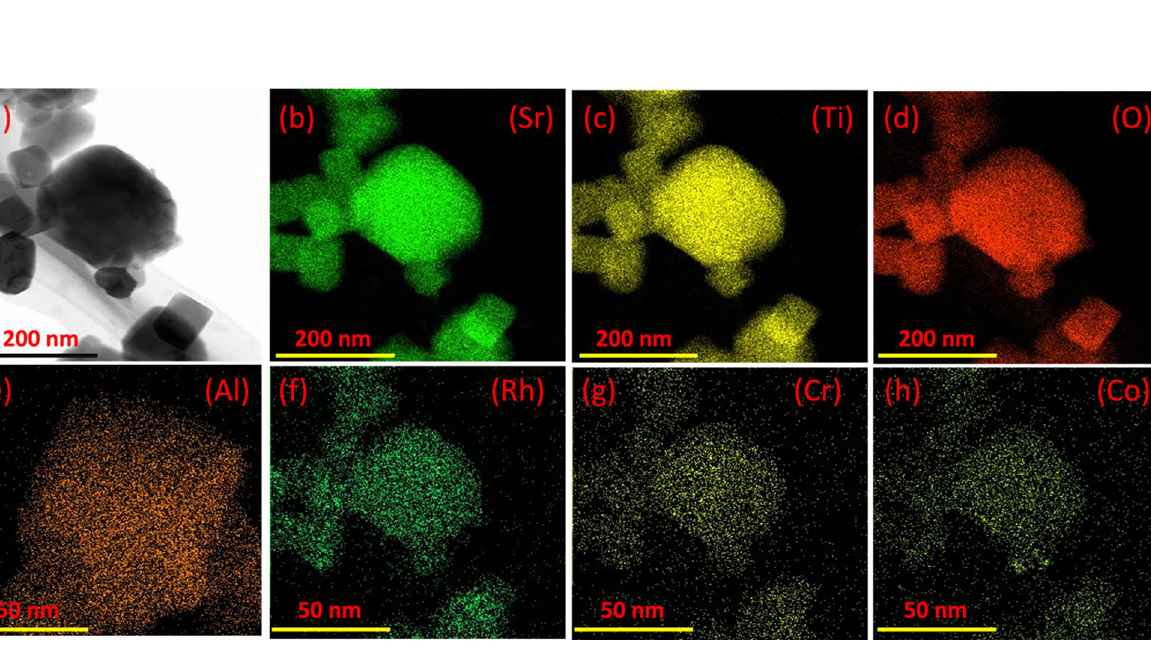
Figure 6. ( a ) TEM analysis and ( b – h ) STEM mapping analysis of the prepared cocatalysts over Al-SrTiO 3